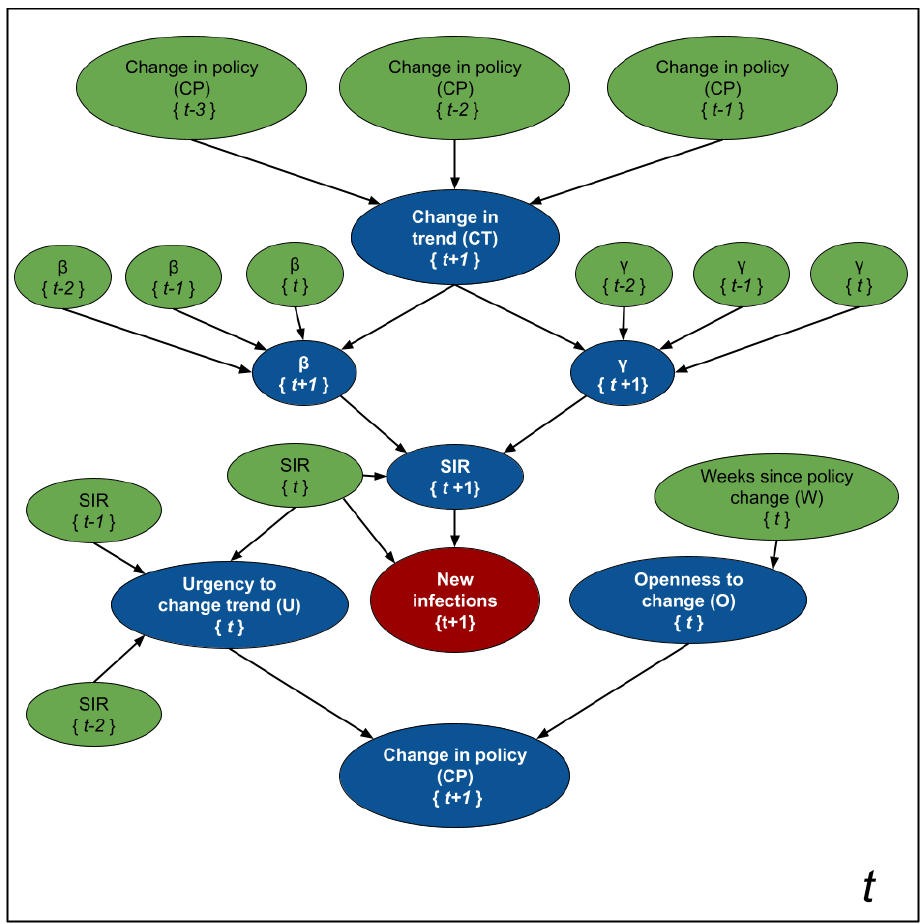
Figure 3. Modeling SIMLR as a PGM for forecasting new cases of COVID-19. The blue nodes are estimated at each time point, while the green ones are either based on past information, or where estimated in a previous